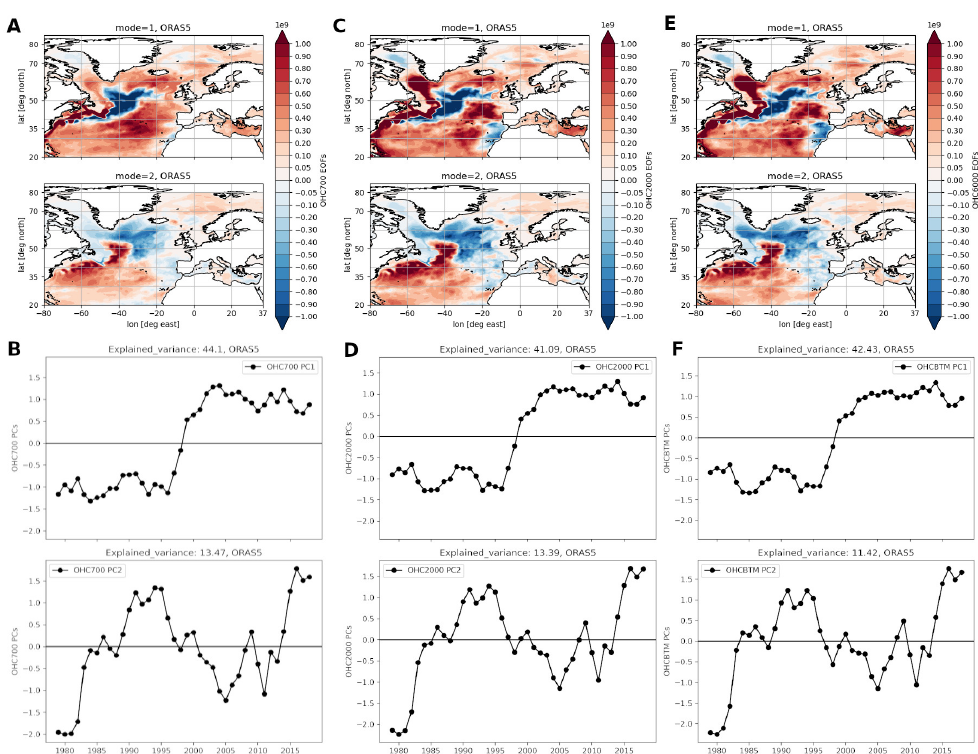
Figure A1. EOF modes and PCs for the OHC in the upper 700 m. Panels ( A , B ): 2000 m. Panels ( C , D ) and, top to bottom, panels ( E , F ): ORAS5.